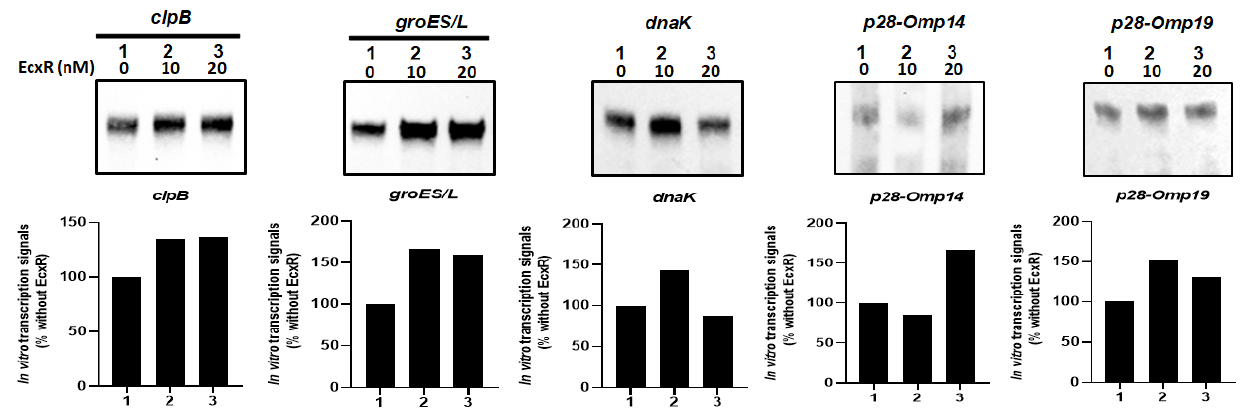
Figure 8. In vitro transcription analysis of the role of protein EcxR on the transcription of the E. chaffeensis promoters, including clpB, groES/L, dnaK , p28-Omp14 and p28-Omp19 . The promoter segments of E. chaffeensis genes, clpB , groES/L, dnaK , p28-Omp14 and p28-Omp19 were cloned upstream to the G-less cassette in pMT504 plasmid vector in the correct orientation and used in the assays with reconstituted RNAP containing E. chaffeensis recombinant σ 32 or σ 70 . In vitro transcription analysis was performed using E. coli RNAP holoenzyme containing E. chaffeensis recombinant σ 32 for clpB, groES/L and dnaK , and E. chaffeensis recombinant σ 70 for p28-Omp14 and p28-Omp19. Lane 1, template DNA with RNAP holoenzyme with no EcxR added. Lanes 2 – 3, template DNA with RNAP holoenzyme and with 10 or 20 nM recombinant EcxR, respectively. The abundance of the transcripts for the template in the presence of σ 32 or σ 70 alone or with recombinant EcxR is captured from the Biotin-14-CTP incorporation in the RNA. The upper panel indicate the transcription products, which were resolved on a 6% denatured polyacrylamide gel containing 7 m urea in 1 × Tris-borate-EDTA buffer. The lower panel indicated the intensity of a band signals in a gel for in vitro transcriptions, as determined using the software ImageJ. The bars show the relative change of transcription products with different concentrations of EcxR as the percentage of transcripts compared to the controls lacking